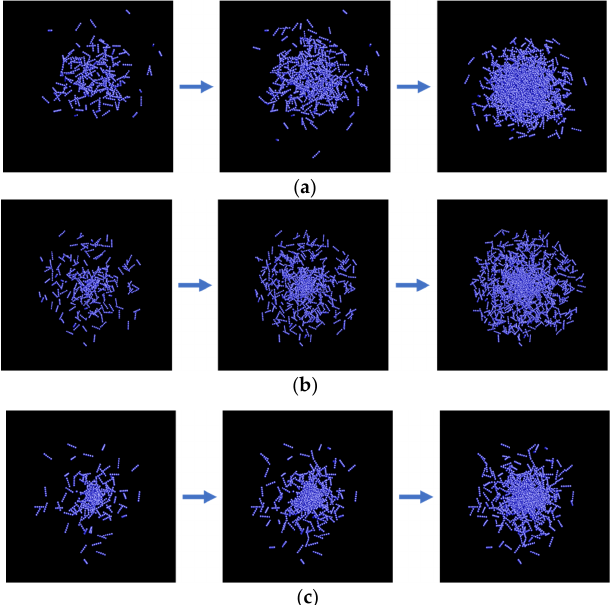
Figure 3. Nanochain cluster models generated using different distribution functions. ( a ) Clusters whose form is represented by Gaussian distribution. ( b ) Clusters whose form is represented by uniform distribution. ( c ) Clusters whose form is represented by Cauchy distribution.